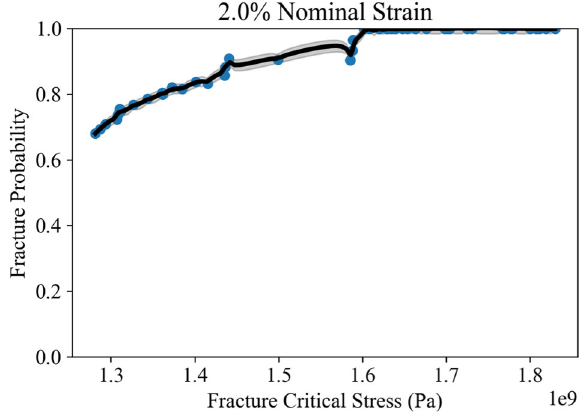
Fig. 7 Fitted GPR representing the failure probability for fracture critical stress levels at 1.25% nominal strain.